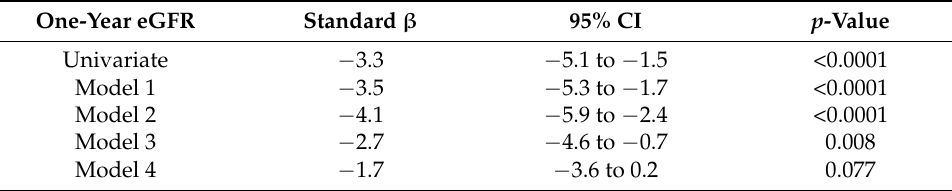
Table 3. Multivariable adjusted associations of the CaScore with one-year eGFR.